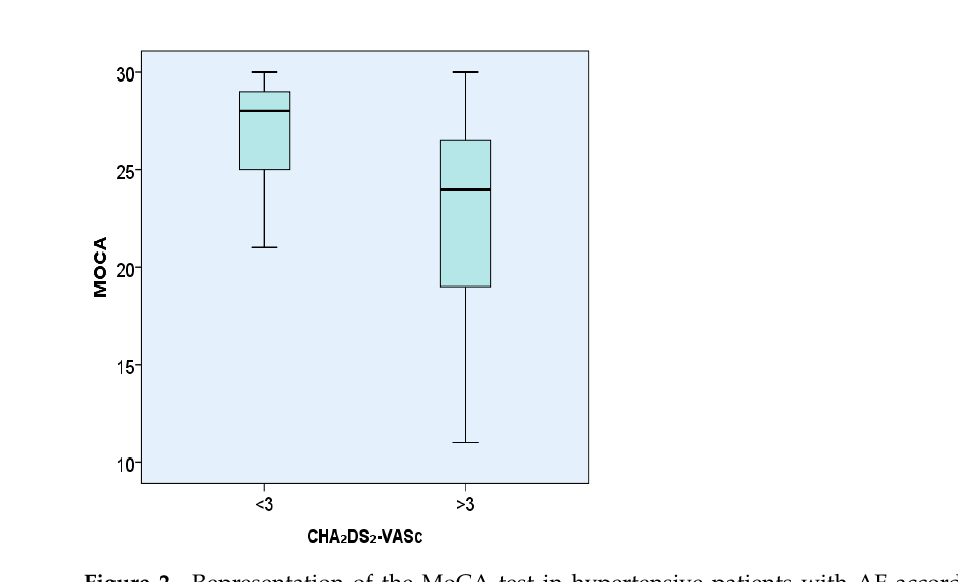
Figure 2. Representation of the MoCA test in hypertensive patients with AF according to the CHA ₂ DS ₂ -VASc score </> 3.